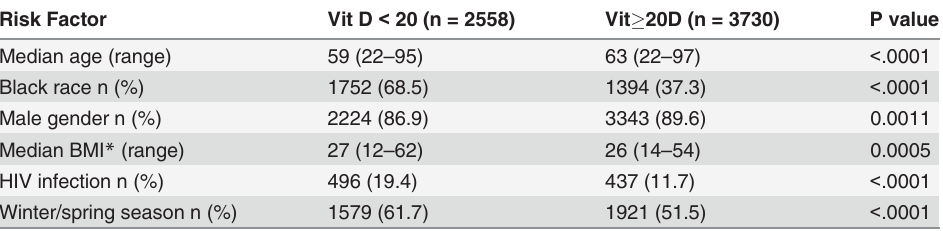
Table 1. Risk factors associated with Vitamin D deficiency, all patients; univariate